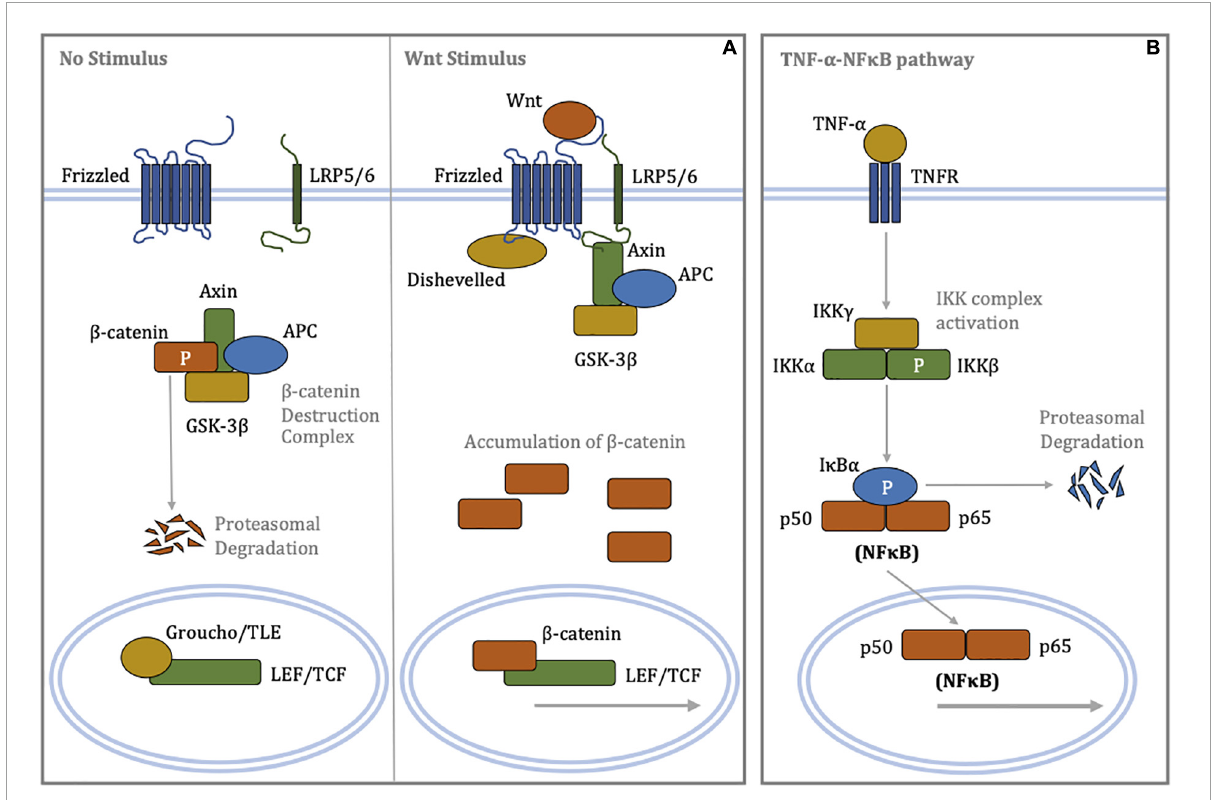
FIGURE1 Schematic diagrams of signal transduction in the canonical Wnt/ β -catenin and canonical TNF- α -NF κ B signaling pathways. (A) (Left panel) In the absence of a Wnt stimulus, β -catenin is phosphorylated by the destruction complex targeting it for poly-ubiquitination and subsequent proteasome-mediated proteolysis. Low cytoplasmic levels of β -catenin permit repression of LEF/TCF-dependent transcription by Groucho/TLE. (Right panel) Binding of Wnt ligands to the Frizzled/LRP5/6 receptor complex promotes recruitment of Disheveled and Axin, resulting in disassembly of the β -catenin destruction complex. Cytoplasmic accumulation of β -catenin allows for its nuclear translocation, where β -catenin displaces Groucho/TLE from LEF/TCF, enabling transcriptional regulation. (B) Binding of the TNF- α ligand to the TNF receptor recruits, phosphorylates and activates the IKK complex via oligomerisation of a series of adaptor proteins. In turn, the activated IKK complex phosphorylates I κ B α , resulting in poly-ubiquitination of I κ B α and its rapid proteasomal degradation. The unbound NF κ B heterodimer complex, where p50 and p65 are members of NF κ B family, translocates to the nucleus and regulates transcription of target genes involved inflammation. APC, adenomatous polyposis coli; GSK-3 β , glycogen synthase kinase-3 β ; I κ B α , inhibitor of κ B- α ; IKK, I κ B kinase; LEF, lymphoid enhancer-building factor; LRP5/6, lipoprotein receptor-related protein 5/6; NF κ B, nuclear factor kappa-light-chain-enhancer of activated B cells; P, phosphorylation; TCF, T-cell factor; TLE, transducin-like enhancer of split; TNF- α , tumor necrosis factor- α ; TNFR, tumor necrosis factor